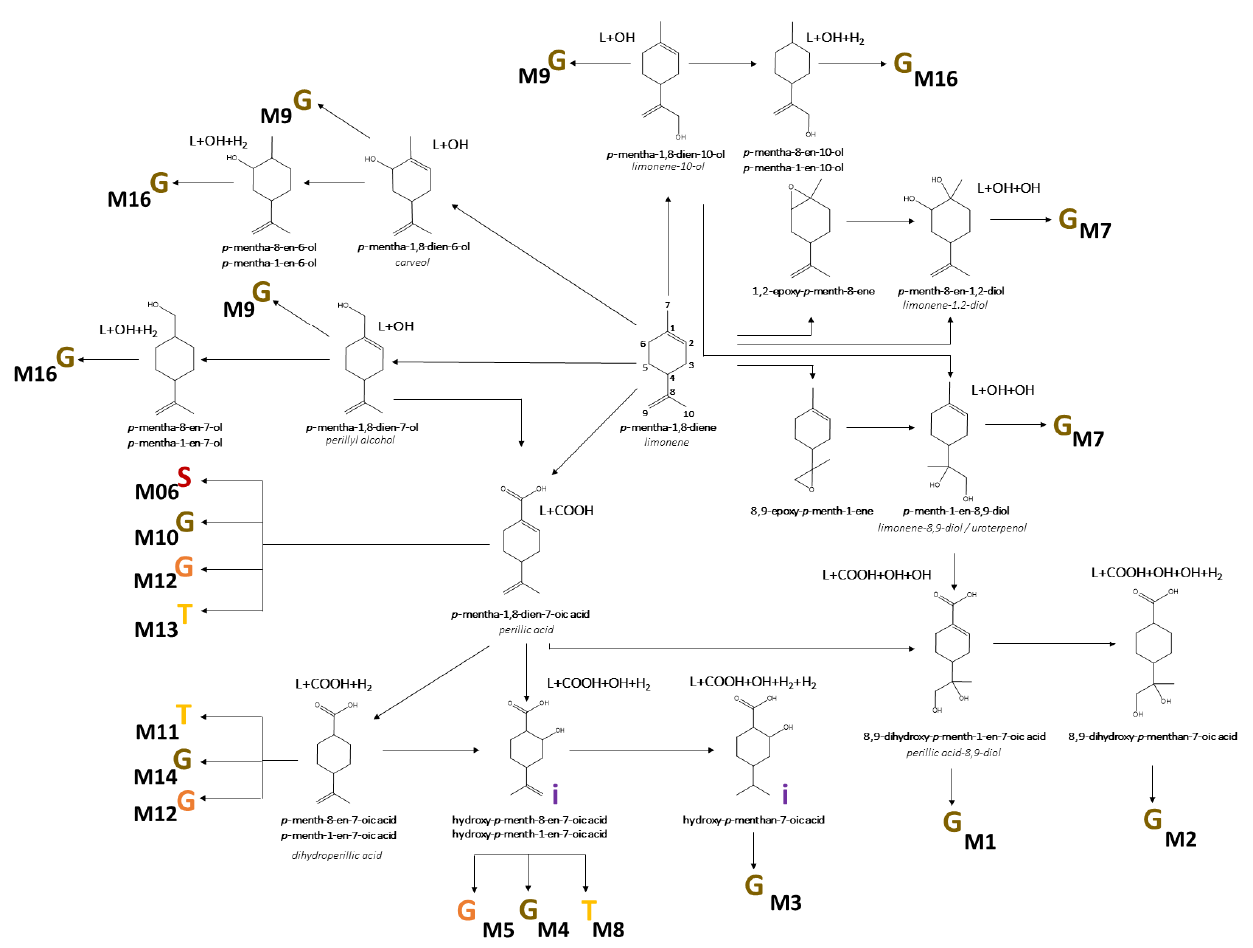
Figure 1. Metabolic map of possible metabolism pathways used for D-limonene excretion. Phase II metabolites were indicated as glucuronide (brown G), sulfate (S), glycine (orange G), and taurine (T). Isomers were indicated by i.